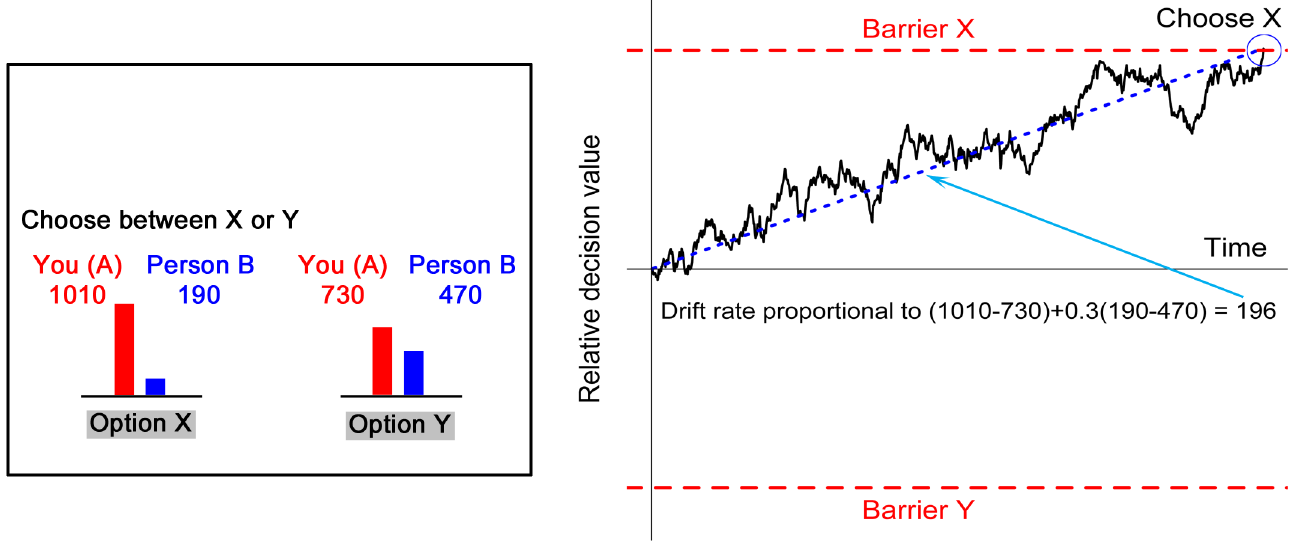
Fig 1. An example of a decision from Task 1, with selfish option X on the left and the fairer option Y on the right along with a simulated decision for this example, using the social aDDM with the parameters from the food study. The drift rate (dotted blue line) is proportional to the weighted sum of the payoff differences for each player between options X and Y. The weight of 0.3 is the discount parameter θ